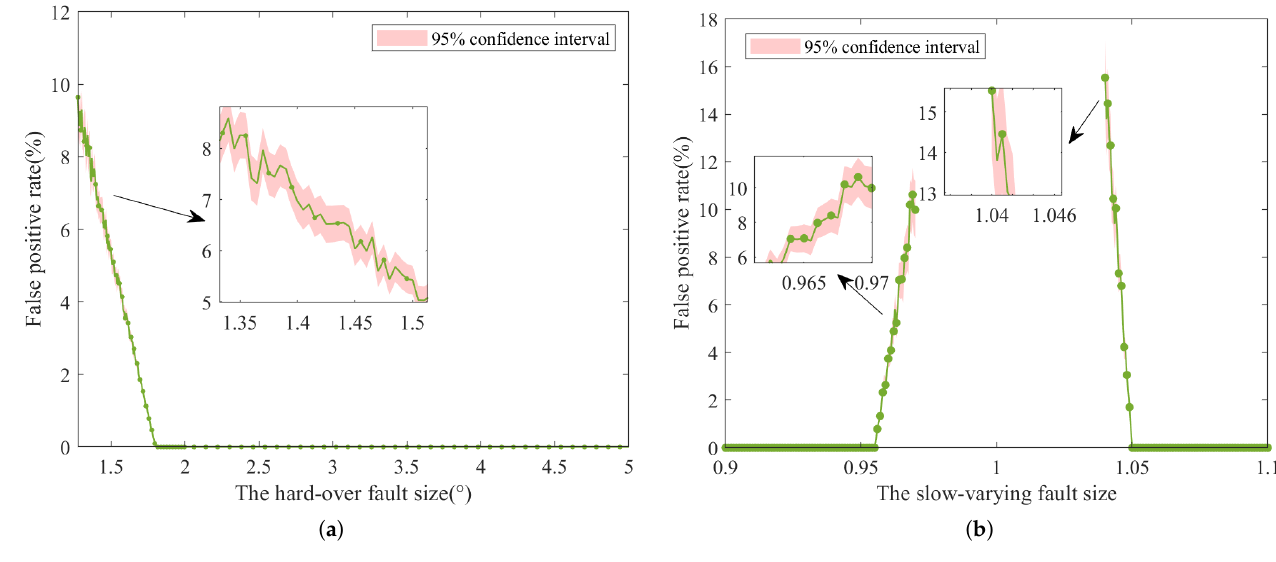
Figure 9. Fault diagnosis result of Monte Carlo experiments. ( a ) The FPR of the slow-varying fault when the hard-over fault occurs. ( b ) The FPR of the normal state when the slow-varying fault